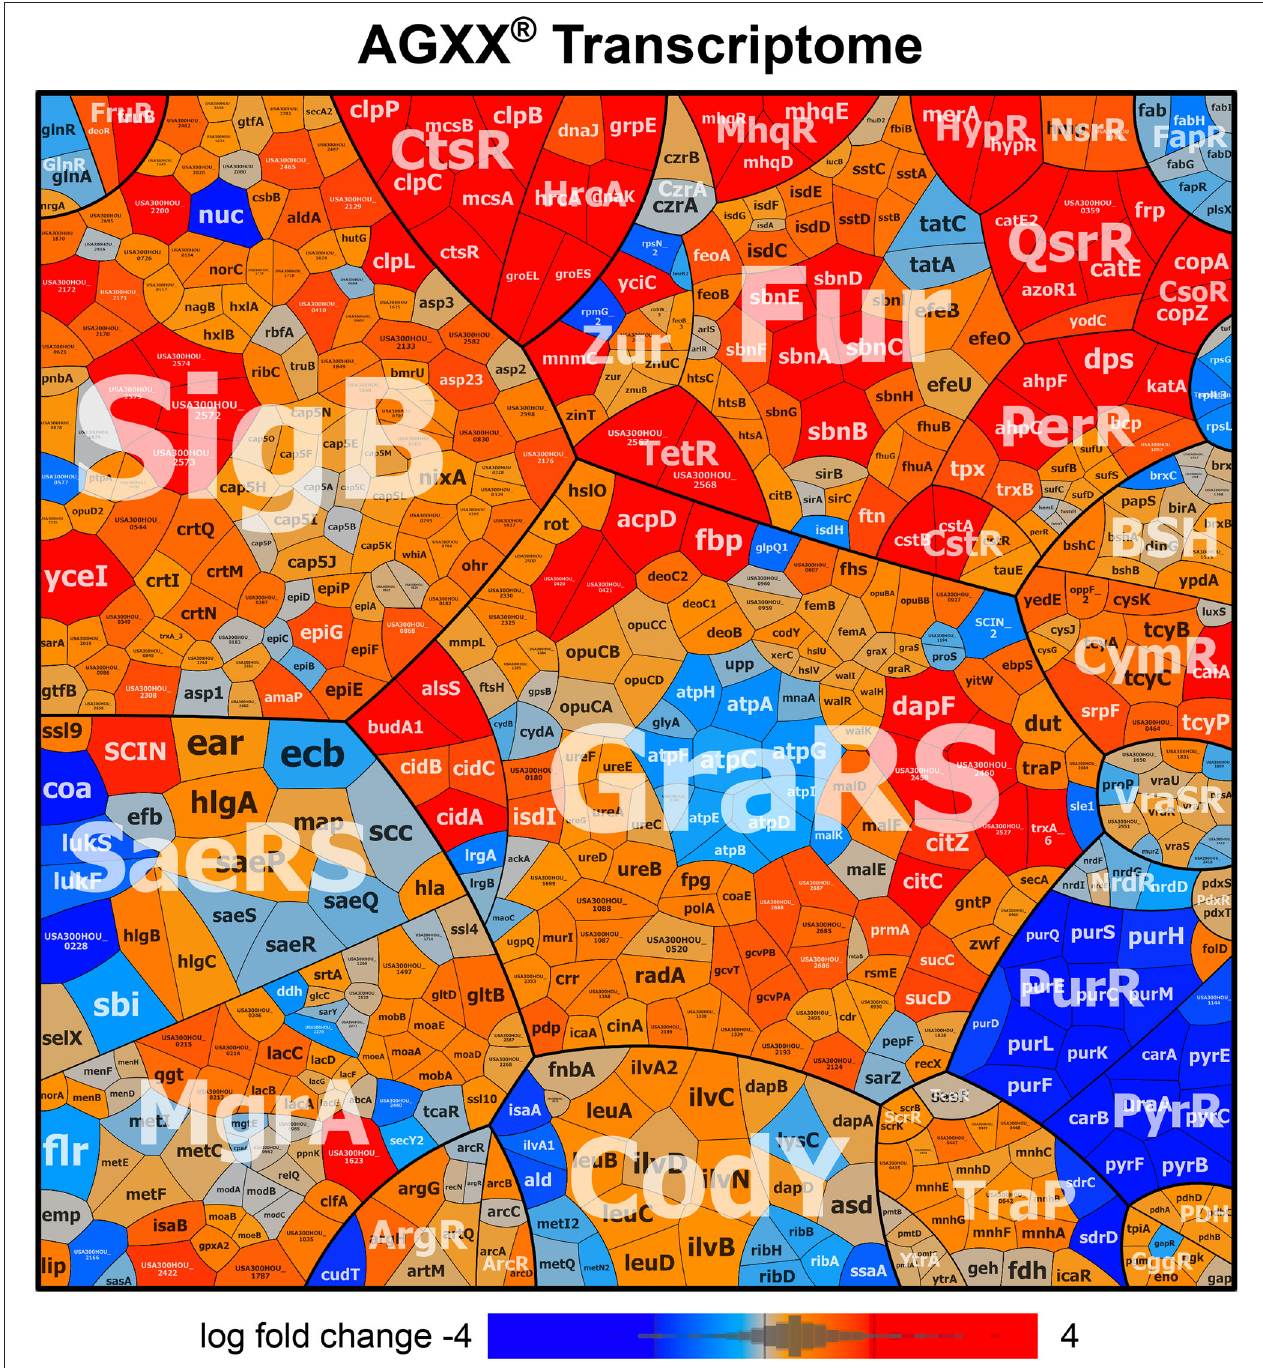
FIGURE 3 | AGXX ® induces a strong thiol-specific oxidative and metal stress response in the RNA-seq transcriptome of S. aureus USA300. The treemap shows the log2-fold changes (M-values) for the induction and repression of selected regulons after exposure to 4.5 µ g/ml AGXX ® stress in the RNA-seq transcriptome of S. aureus USA300. The genes are classified into operons and regulons based on the RegPrecise database (http://regprecise.lbl.gov/RegPrecise/index.jsp) and previous studies ( Mäder et al., 2016). Log2-fold changes in gene expression are visualized using a red-blue color code where red indicates log2-fold induction and blue repression of transcription under AGXX ® exposure. AGXX ® caused a strong thiol-specific oxidative and metal stress response and protein damage as shown by the strong induction of the PerR, HypR, QsrR, MhqR, CtsR, HrcA, and CstR regulons in S. aureus USA300. The induction of the CsoR, Fur, Zur, SigmaB, and GraRS regulons further indicates metal stress, cell wall and general stress responses in S. aureus . The detailed transcriptome data of all differentially expressed genes in response to AGXX ® stress are presented in Tables S1, S2 .